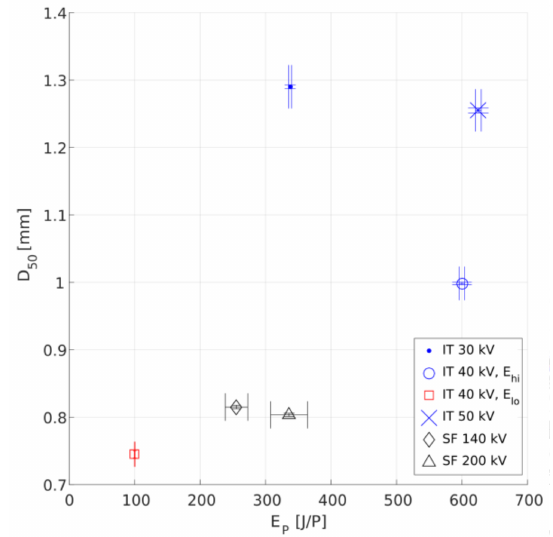
Figure 4. Energy of individual pulses (E P ) and median particle size (D 50 ) of individual test